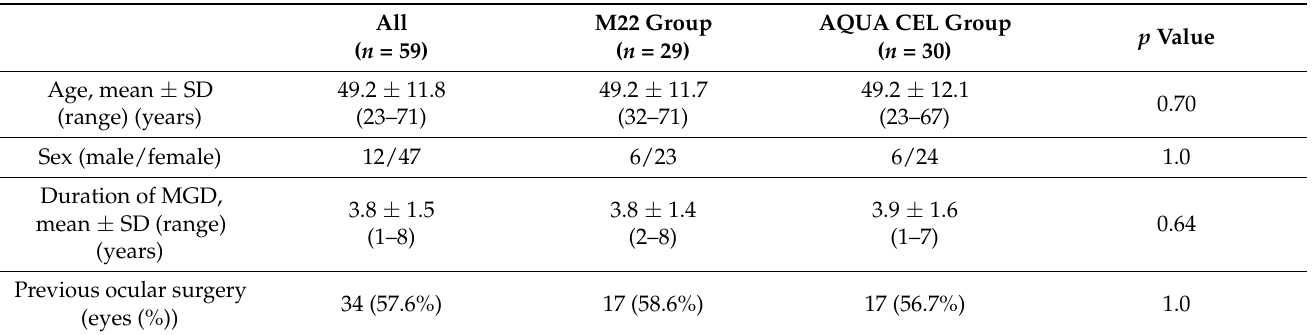
Table 2. Baseline characteristics of the intense pulsed light (IPL) therapy with M22 and AQUA CEL groups of study subjects with meibomian gland dysfunction (MGD).